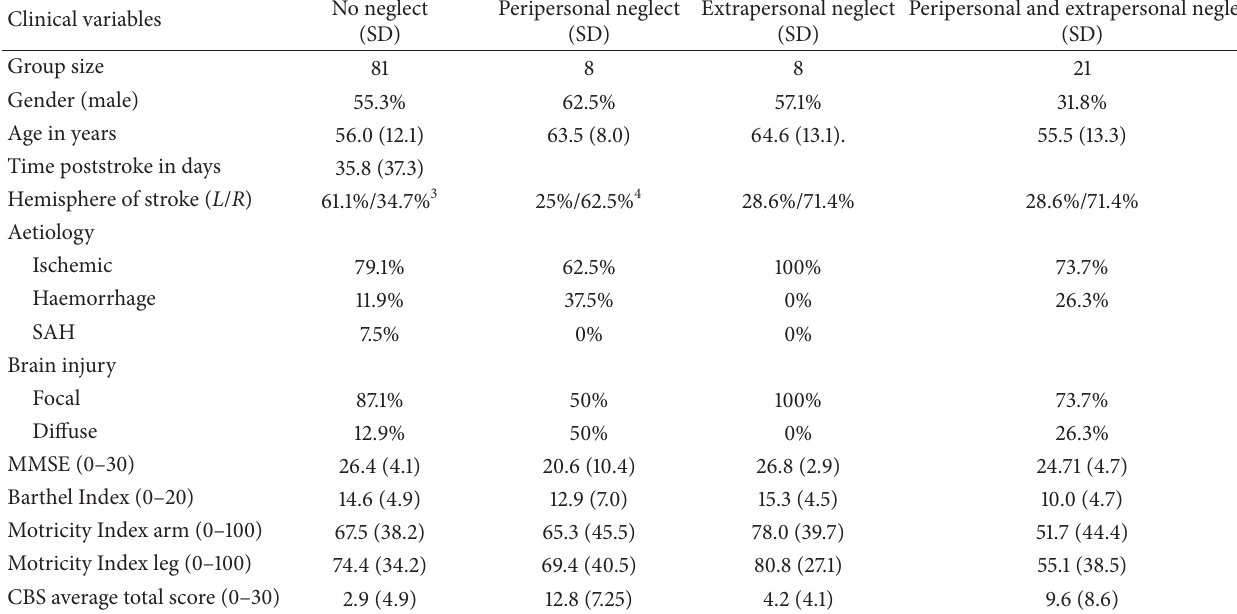
Table 2: Clinical characteristics and average total scores on the CBS per group (nonneglect, peripersonal neglect, extrapersonal neglect, both regions, based on a shape cancellation).